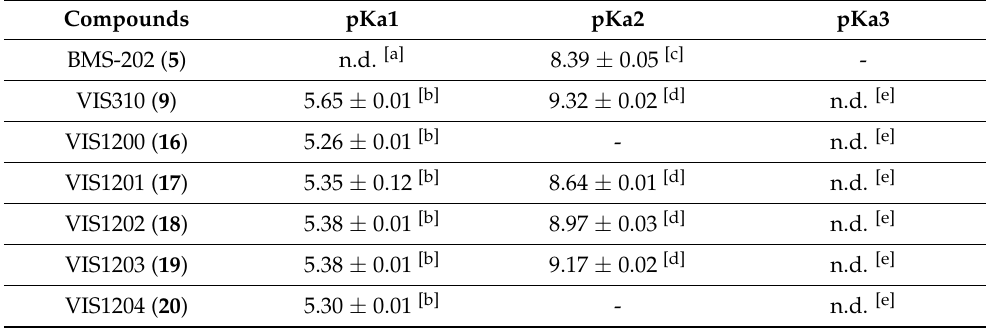
Table 3. Acid dissociation constants (pKa) of BMS-202 ( 5 ), VIS310 ( 9 ), and analogues ( 16 – 20